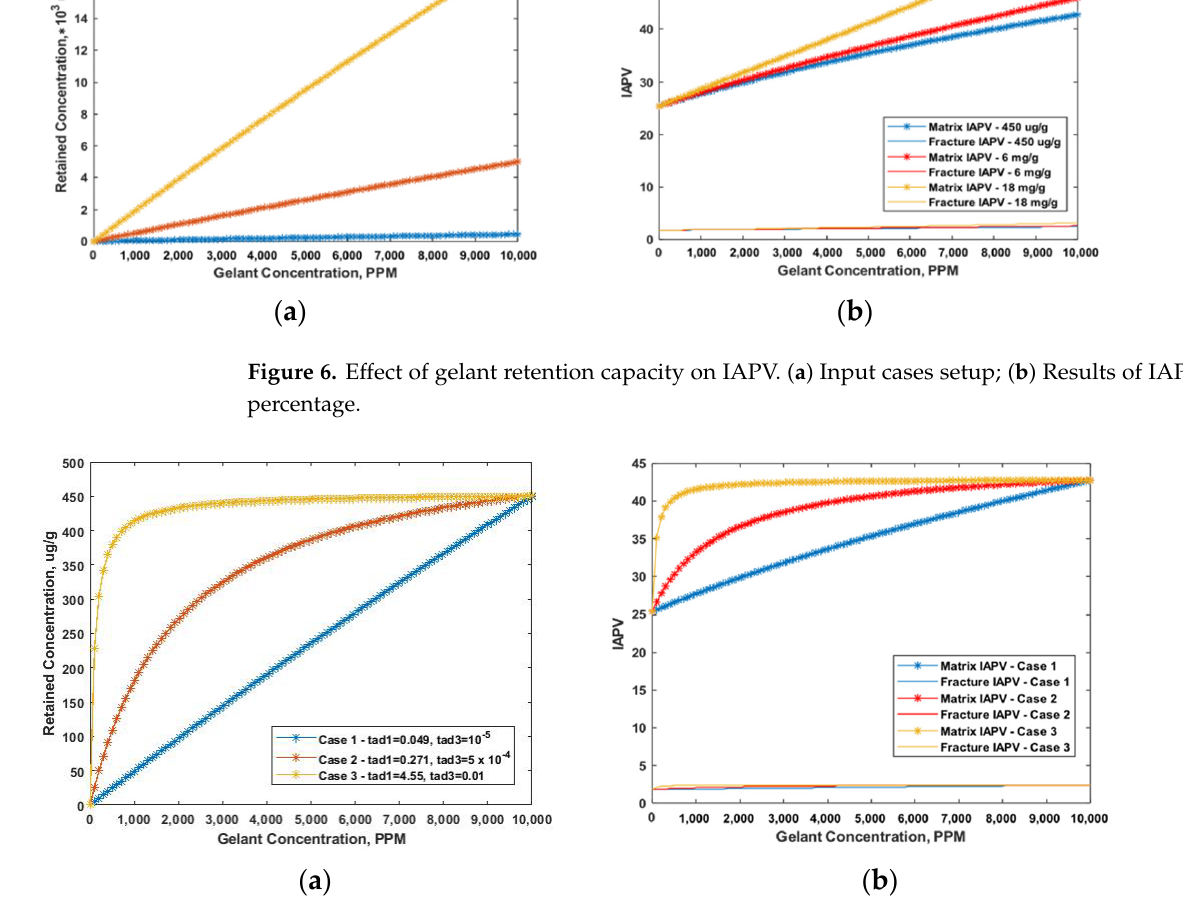
Figure 7. Effect of gelant retention rate on IAPV. ( a ) Input cases setup with varied Langmuir model coefficients; ( b ) Results of IAPV in percentage.